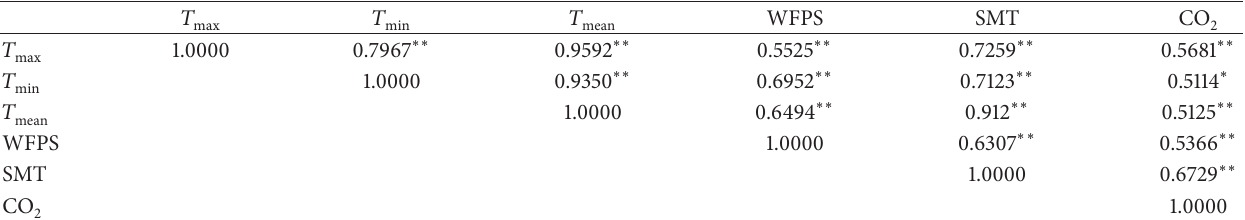
and same soil 2